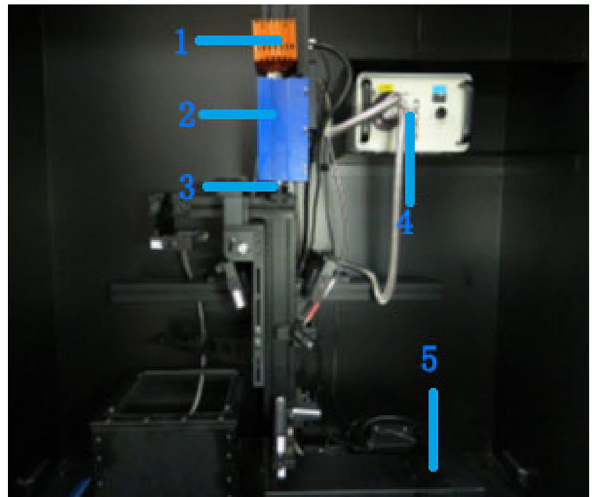
Figure 4. (1) High-sensitivity EM285CL EMCCD camera. (2) ImSpector V10E imager. (3) Camera lens. (4) IT 3900 halogen light source. (5) Scanning